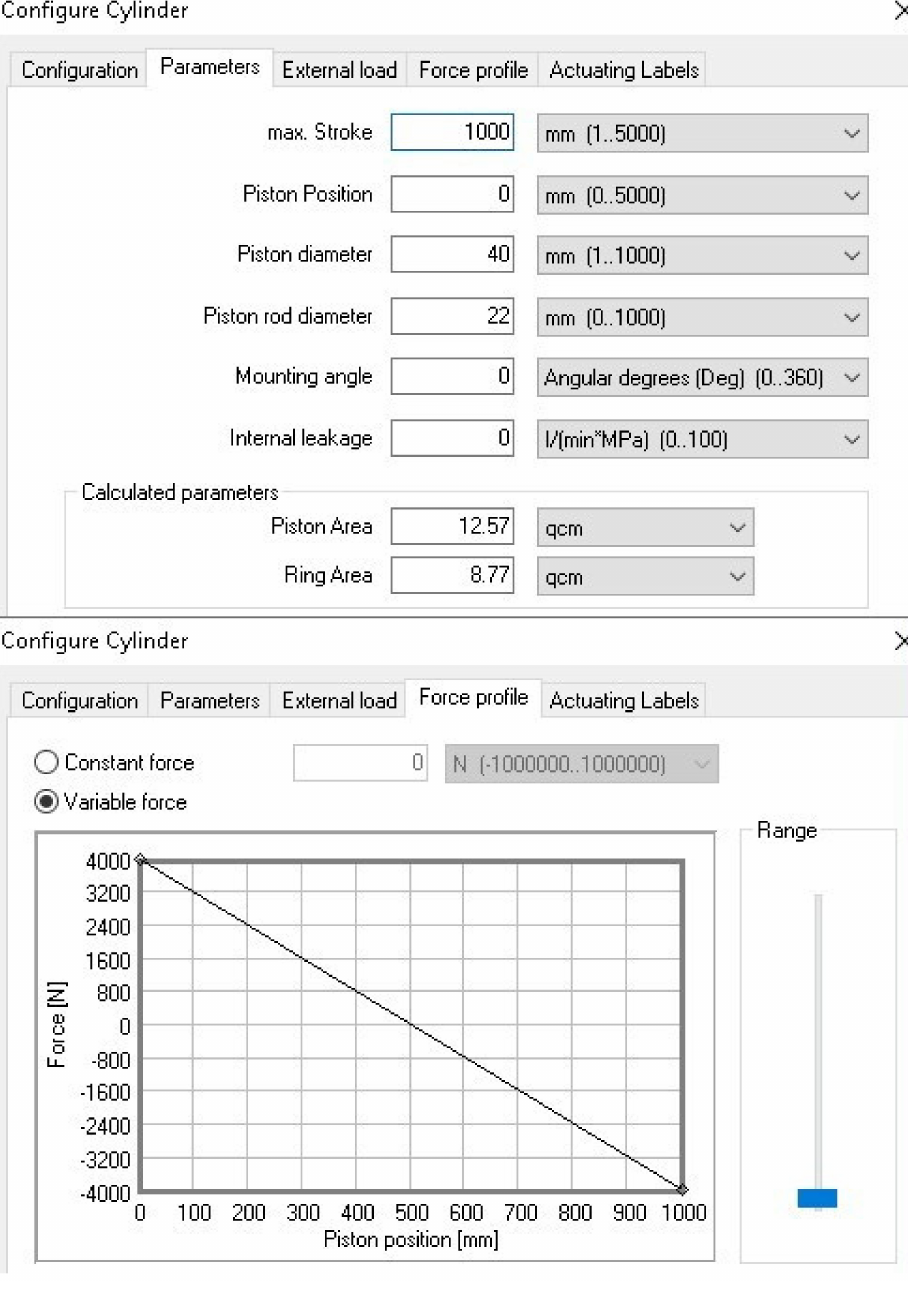
Figure 17. Actuator parameters